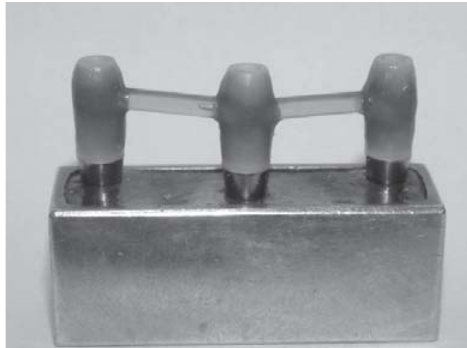
FIGURE 1- Waxed-up bar incorporating prosthetic